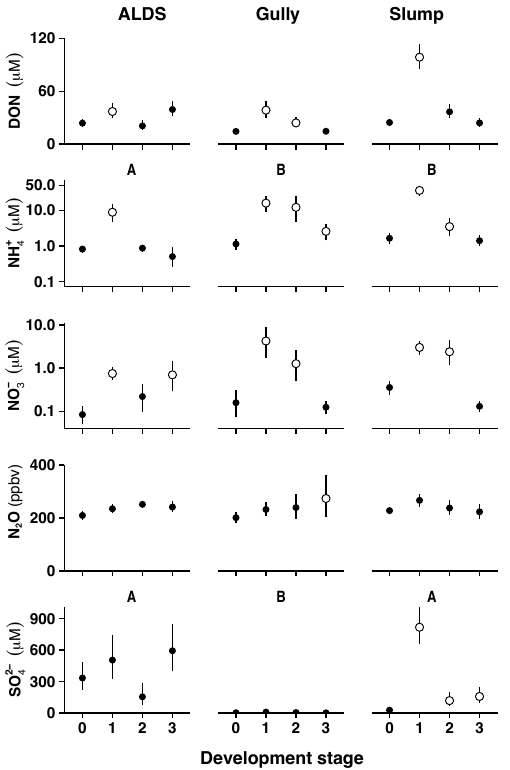
Figure 4. Dissolved carbon species and characteristics in outflow from 22 active-layer detachment slides, 19 thermo-erosion gullies, 42 thaw slumps, and 61 reference features in upland tundra on the North Slope of Alaska. Open circles signify statistical difference from stage-0 undisturbed sites, α = 0.05. Different letters above panels represent significant differences between feature types. Er- ror bars represent SE estimated by mixed-effects ANOVA after ac- counting for between-site variability. See Table 1 for complete def- inition of development stages: 0, reference; 1, most active; and 3, stabilized. Note the log scale for CH 4 .